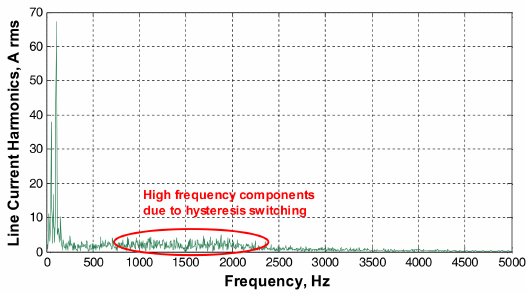
Figure 14. Harmonic spectrum of the APF line current showing the effect of hysteresis switching (simulation results).